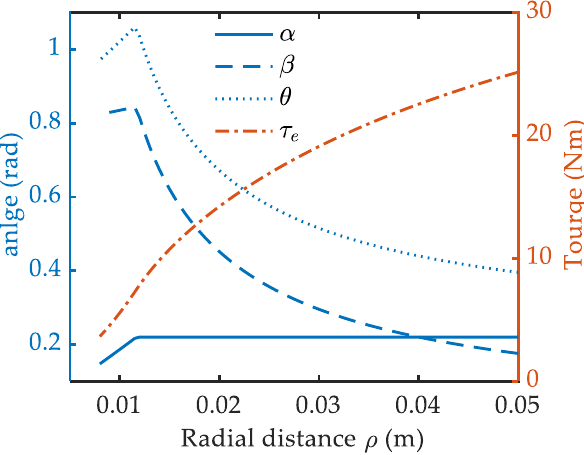
Figure 4. Specification constraints of the variable stiffness module.